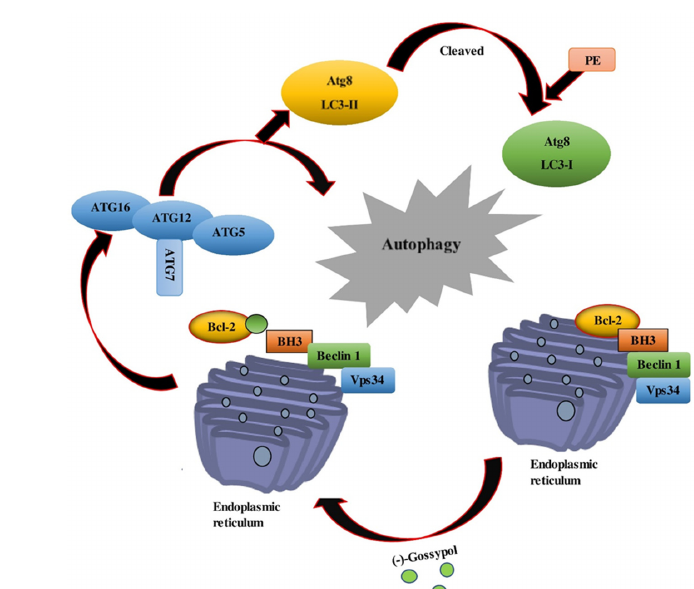
Figure 5. ( − )-Gossypol was found to be more effective at inducing autophagy in apoptosis-resistant Figure 5. ( − ) ‐ Gossypol was found to be more effective at inducing autophagy in apoptosis ‐ resistant cancer cells with high Bcl-2 and Bcl-xL cancer cells with high Bcl ‐ 2 and Bcl ‐ xL levels.